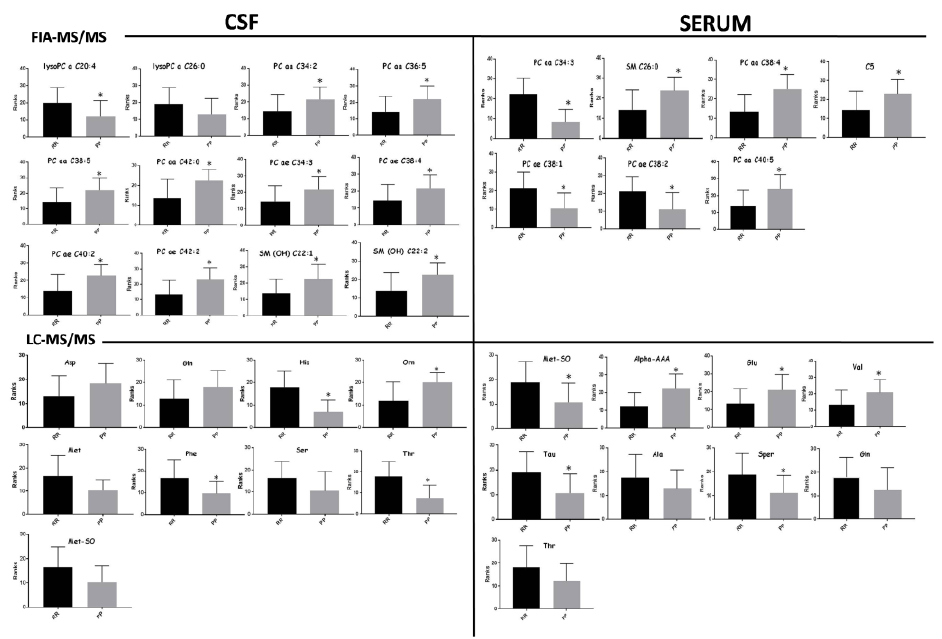
Figure 2. Univariate analysis. Bar-plot of the most discriminant metabolites resulting from the analysis of CSF and serum analyzed with FIA-MS / MS and LC-MS / MS. The black bar indicates the average concentration of the relapses and remissions (RRMS) class expressed as ranks, while the grey bar indicates the average concentration of the PPMS class expressed as ranks. Stars indicate significant change in the concentration of the metabolites.